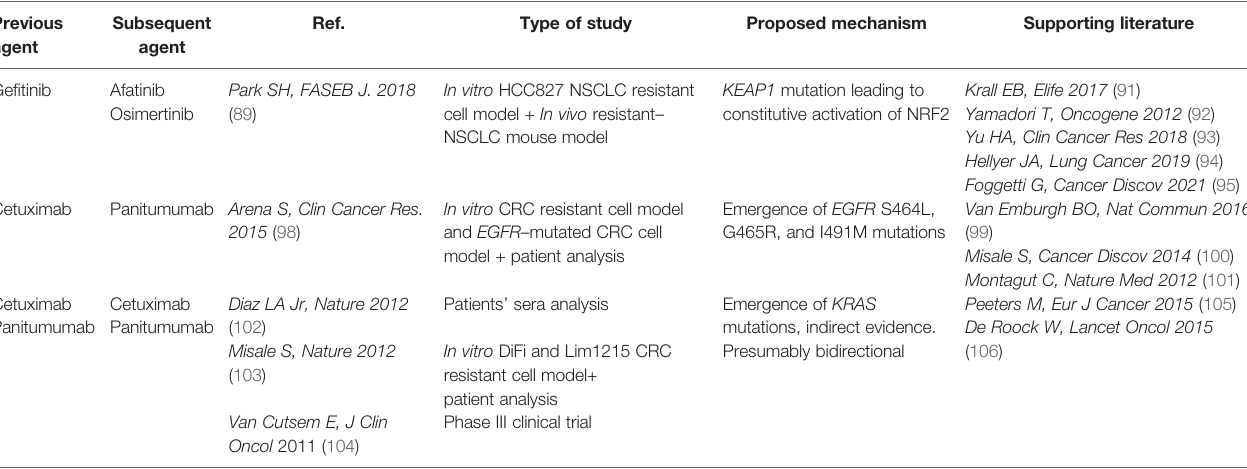
TABLE 3 | Cross – resistance in EGFR – targeted